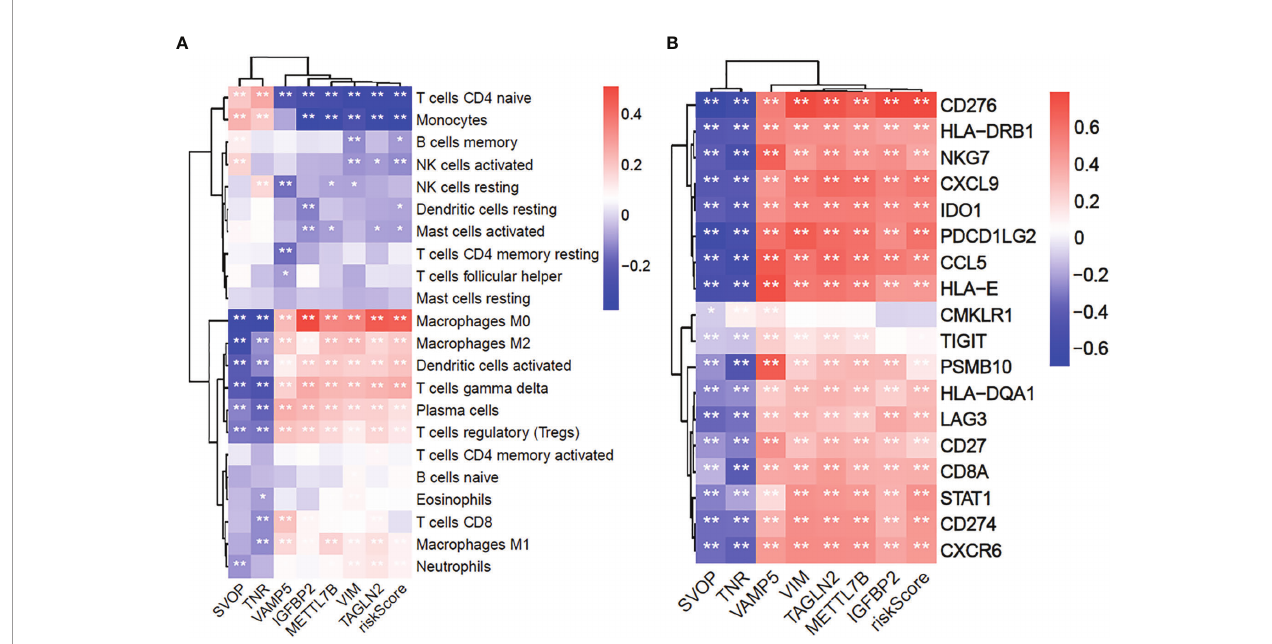
FIGURE 8 | The 7 core prognostic genes of glioma are signi fi cantly related to immune cells in fi ltration and GEP genes. (A) The correlation between 7 prognostic hub genes and 22 immune cells in fi ltration. (B) The correlation between 7 prognostic hub genes and 18 GEP expression. *P ≤ 0.05, **P ≤